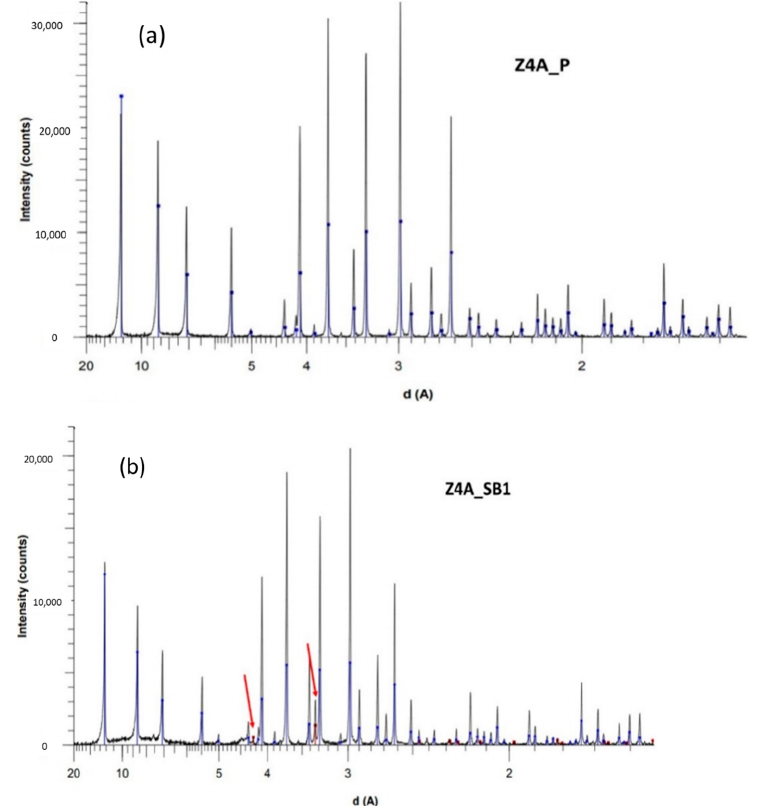
Figure 7. Comparison between X-ray diffractograms on the 4A zeolite samples. Experimental patterns of ( a ) the 4A powder samples, and ( b ) the 4A beads samples. Blue lines indicate the theoretical peak position of the ICDD PDF2 data file of the LTA zeolite, red lines indicate the theoretical peak position of the suggested SiO 2 phase (highlighted by the arrow symbols).